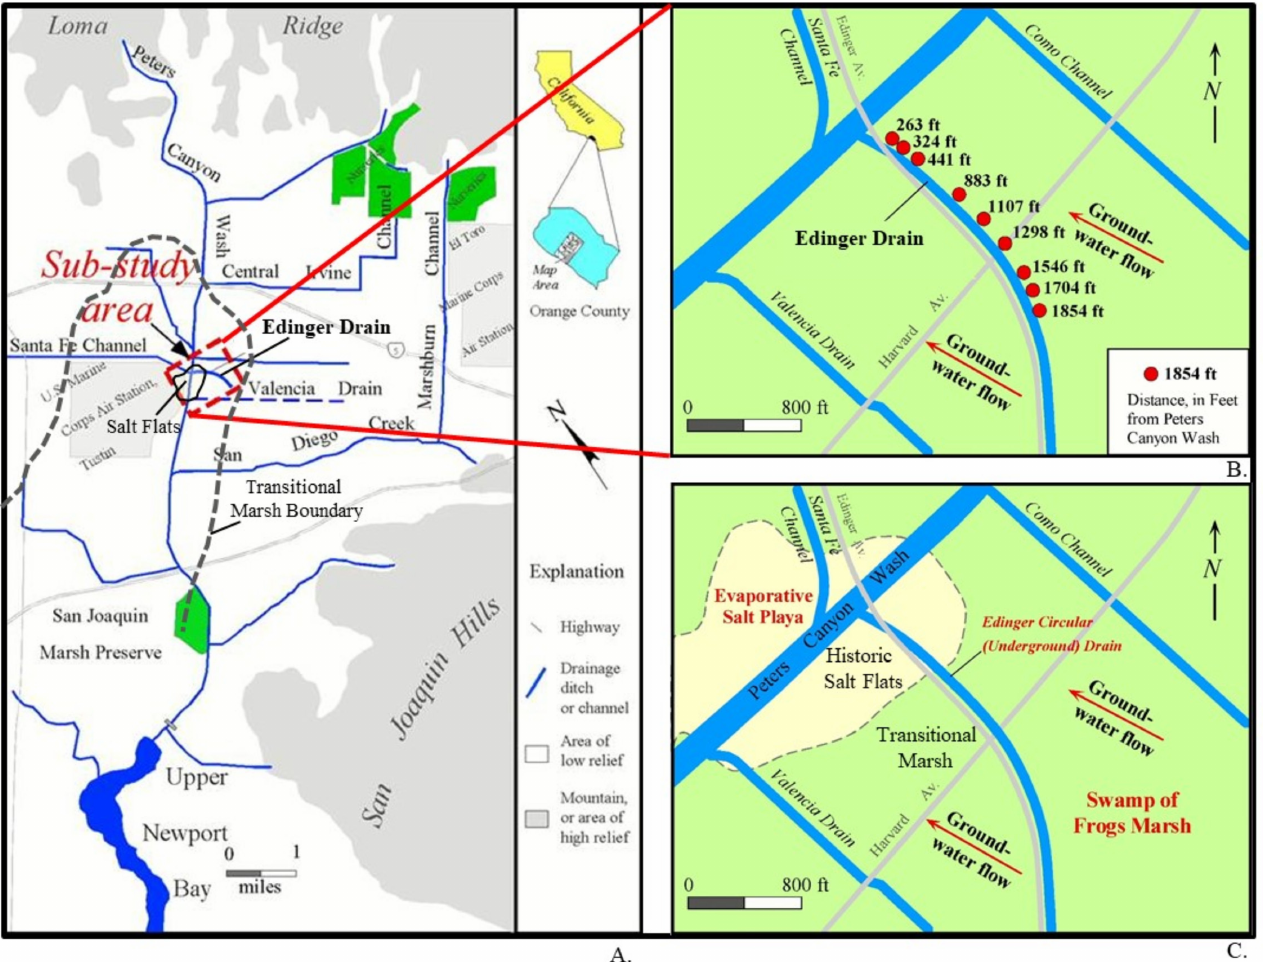
Figure 8. Physiographic features in San Diego Creek Watershed ( A ), and Edinger Drain study area ( B ), showing groundwater sampling points at springs and seeps issuing into Edinger Drain. The distance from groundwater seepage points to Peters Canyon Wash identified the groundwater sampling points in red dots. Edinger drain crosses an interpreted historic alkali flat (i.e., evaporative salt playa; or phreatic playa) that is an important source of high arsenic in the area ( C